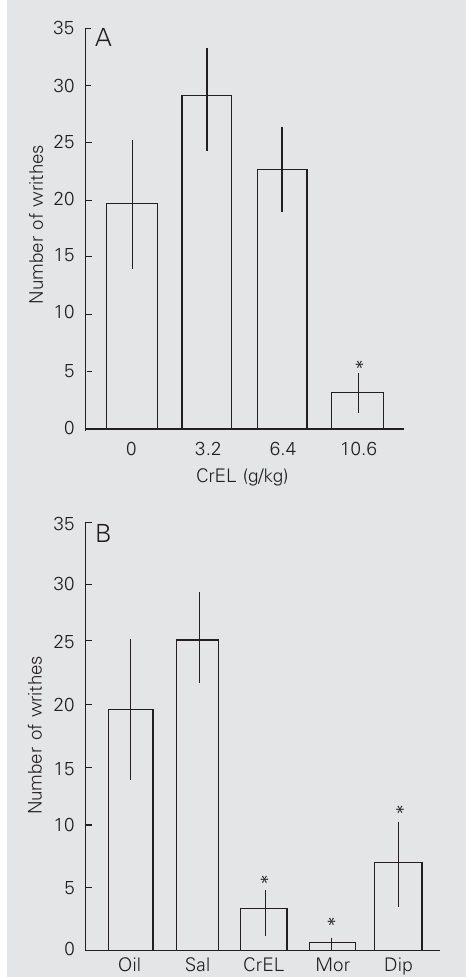
Figure 1. Effect of Cremophor EL (CrEL) (A) and comparison between the effects of CrEL (10.6 g/kg), morphine (20 mg/ kg) and dipyrone (300 mg/kg) (B) on the number of writhes in- duced by acetic acid in mice. *P<0.005 compared with the Oil group (A) or Oil and Sal groups (B) (Student-Newman-Keuls test). Data are reported as means ± SEM for 5 animals in each group. Oil: castor oil, Sal: 0.9% saline, Mor: